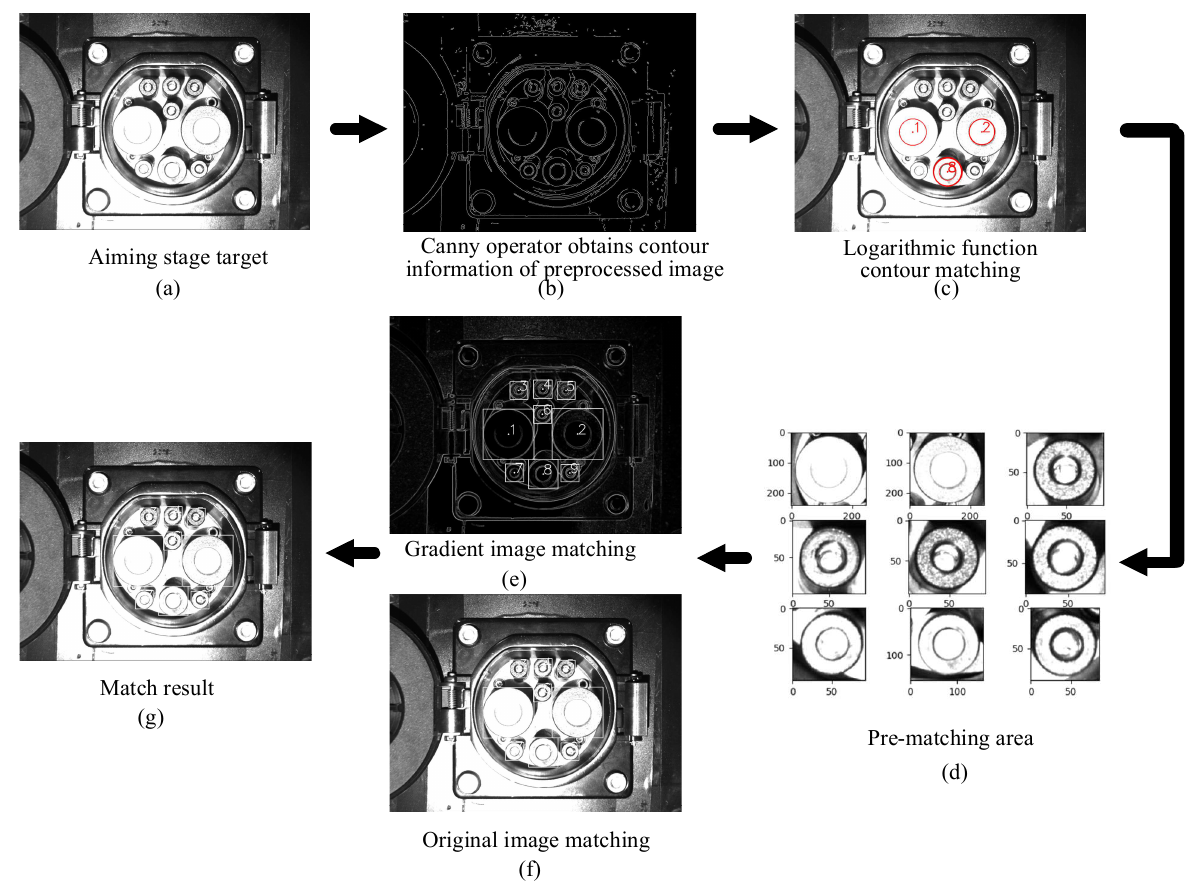
Figure 8. Obtaining feature